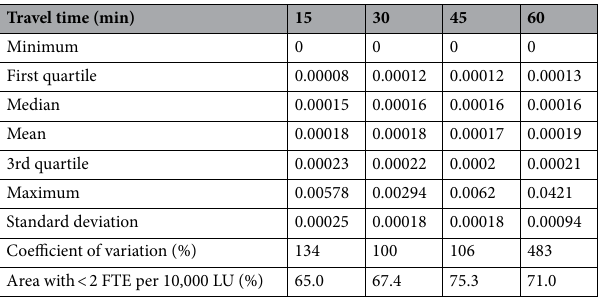
Table 1. 2SFCA accessibility index distribution based on 4 travel time